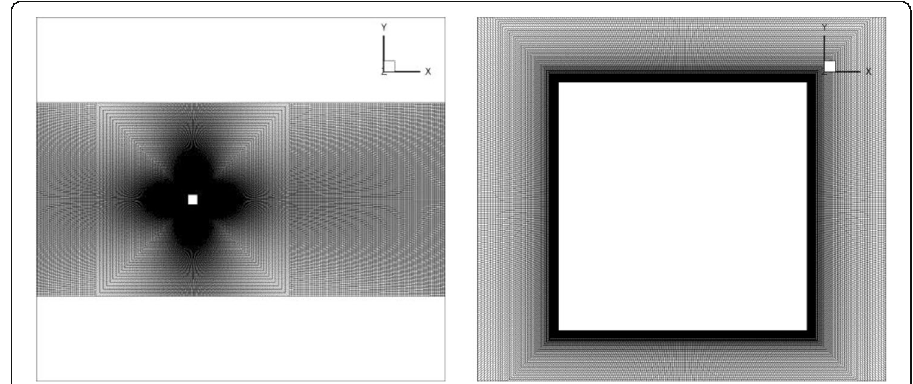
Fig. 1 Computational mesh: whole view (left); around square cylinder (right)